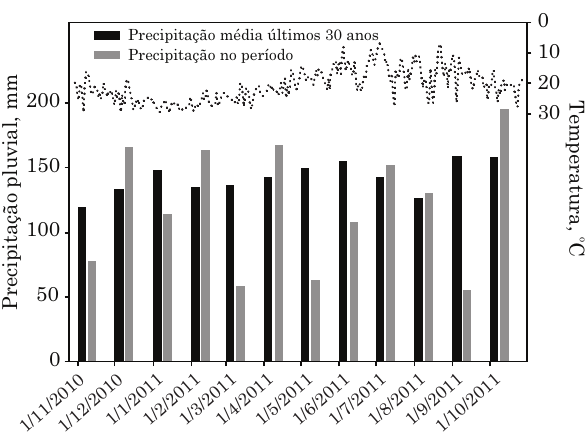
Figura 1. Precipitações pluviais mensais ocorridas, precipitações médias dos últimos 30 anos para o período e temperatura média do ar, durante os cultivos do milho e